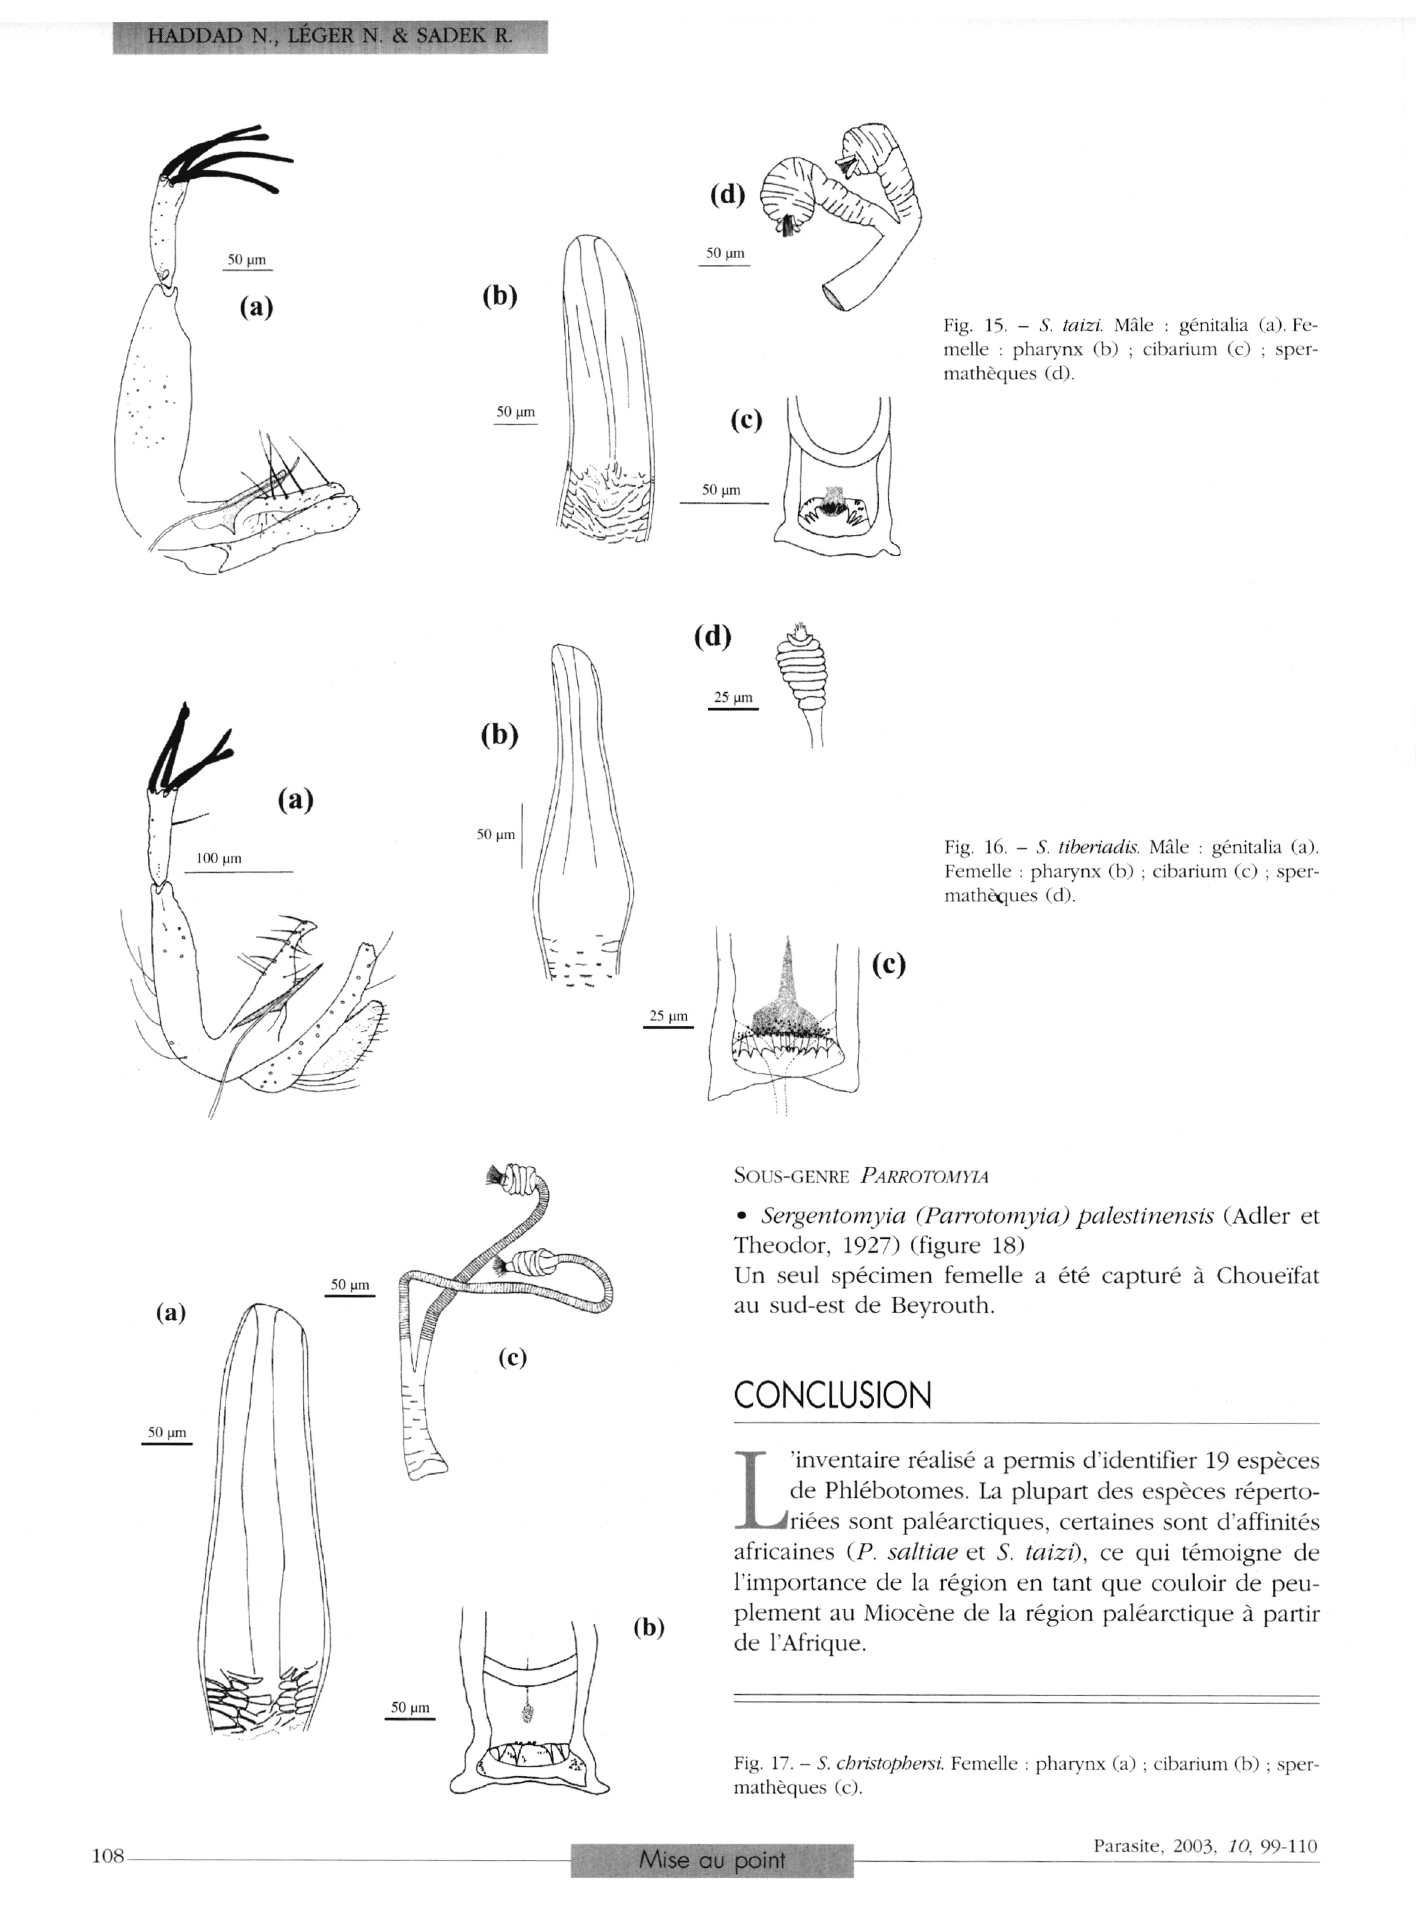
Fig. 15. - S. taizi. Mâle : génitalia (a). Fe­ melle : pharynx (b) ; cibarium (c) ; sper- mathèques (d).